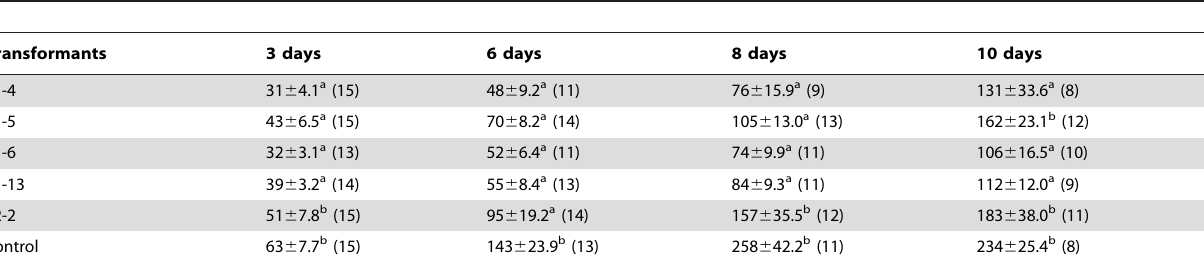
Table 1. Weights of fall armyworm larvae feeding on N. benthamiana T2 homozygous plants transformed with the BvSTI gene.